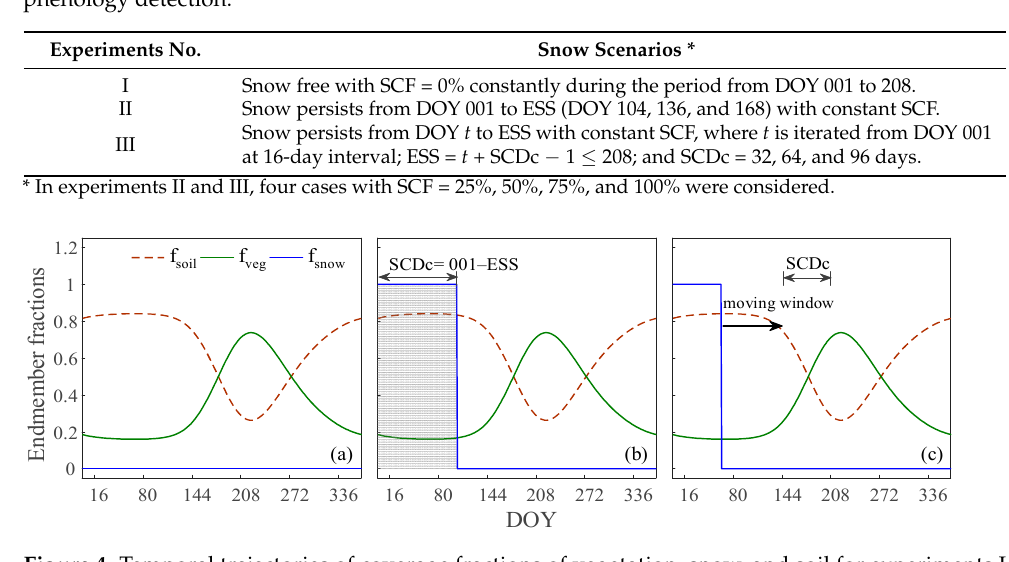
Table 2. Experimental settings for the investigation of the effect of snow on spring vegetation phe- nology detection.